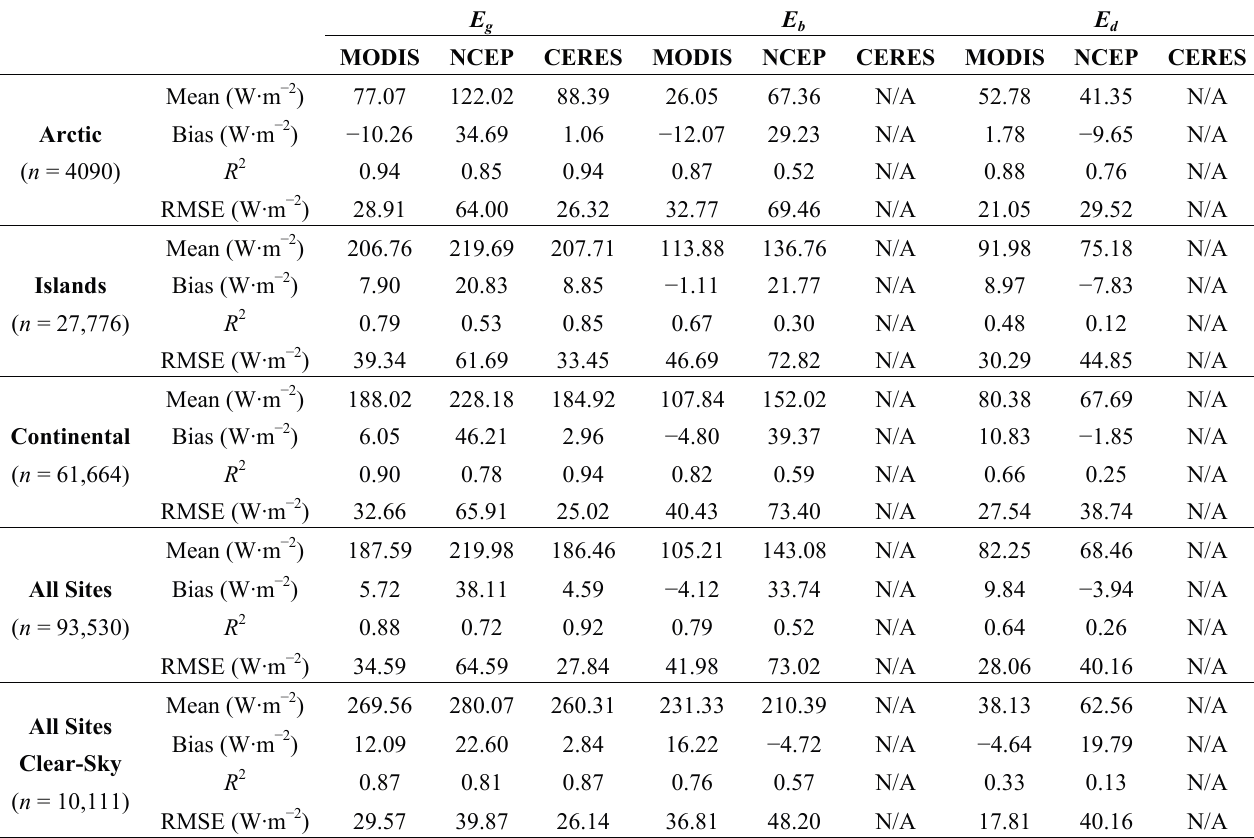
Table 3. Statistics of the MODIS, NCEP and CERES daily total, direct and diffuse solar radiation with BSRN observations for different geographic regions. CERES data only provides E hence no statistics for E and E . n is the number of valid g b d